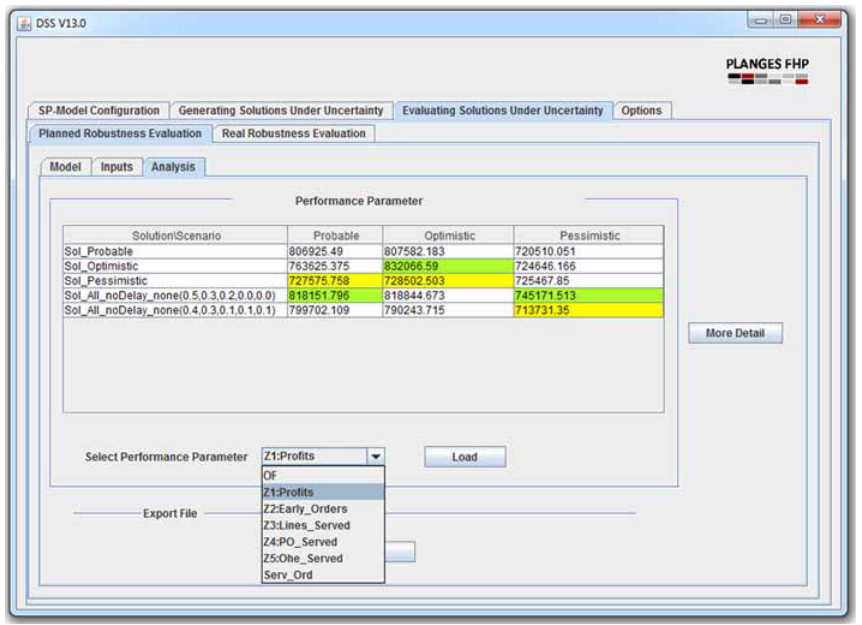
Fig. 8. The “Analysis” Option for the “Planned Robustness Evaluation”